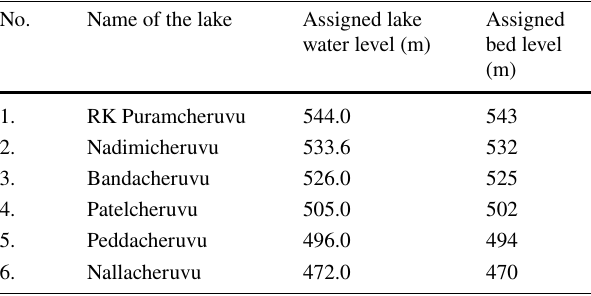
Table 1 Assigned lake water and lake bed levels in the simulated